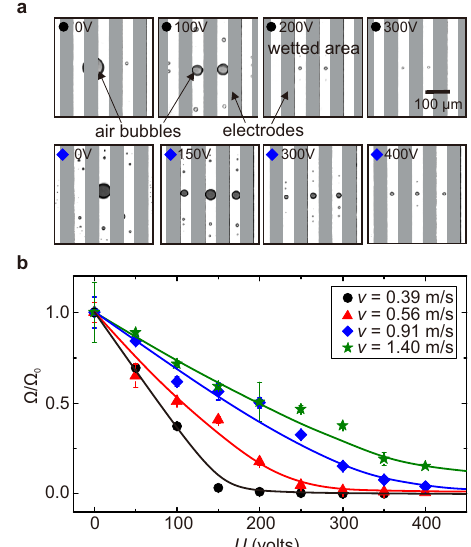
Fig. 3 Elimination of bubble entrapment using the periodic dielectrophoretic effect. a Bottom-view snapshots taken 15 ms after impacts of R = 1.3 mm ethanol droplets for several values of U and for two values of impact velocities, i.e., v = 0.39 m s − 1 (upper panel) and v = 0.91 m s − 1 (lower panel). The surfaces in these snapshots are already wetted except the areas occupied by air bubbles. At U = 0 V, the trapped air fi lm contracts to a large air bubble with radius ≈ 45 μ m; increasing U to 400 V signi fi cantly reduces the bubble ’ s radius. b Plot showing the volume ratio Ω / Ω U for several values of v . Here Ω Ω 0 of the trapped bubbles vs. 0 and are total volumes of air trapped at U = 0 and U > 0, respectively. The error bars represent the standard deviations. The solid lines are to guide the eye. All the impacts shown here do not exhibit bouncing